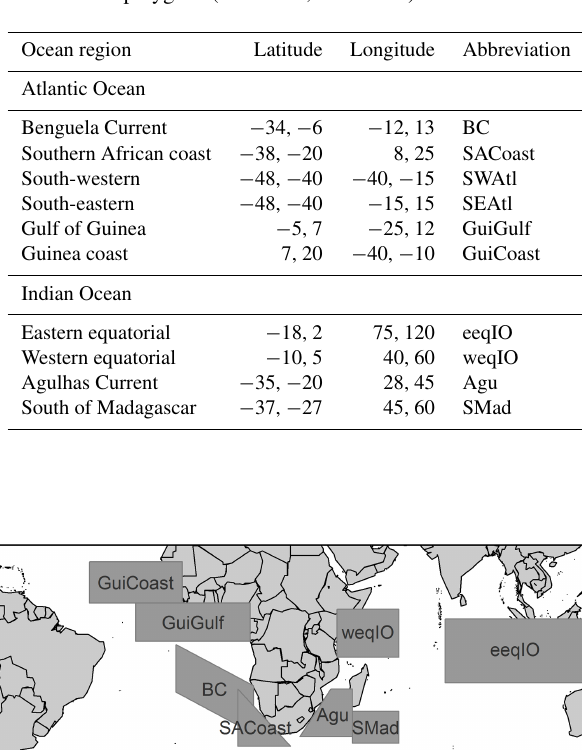
Table 4. Potential customised predictors from ocean regions tele- connected to drought in the Limpopo Basin. Region selection is based on correlation and composite analysis. Coordinates indicate extents of the polygons (minimum, maximum).